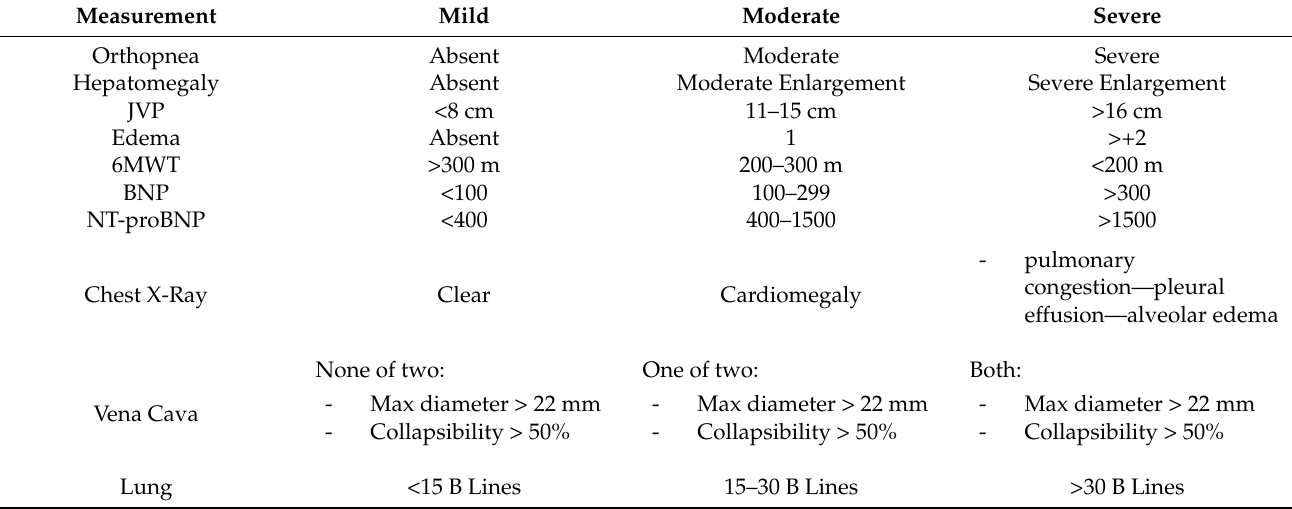
Table 2. Assessment of residual congestion. Adapted from [30]. JVP, jugular venous pulsation, 6MWT: 6-min walk test. BNP: B-type Natriuretic Peptide. NT-proBNP: N-terminal fragment pro B-type Natriuretic